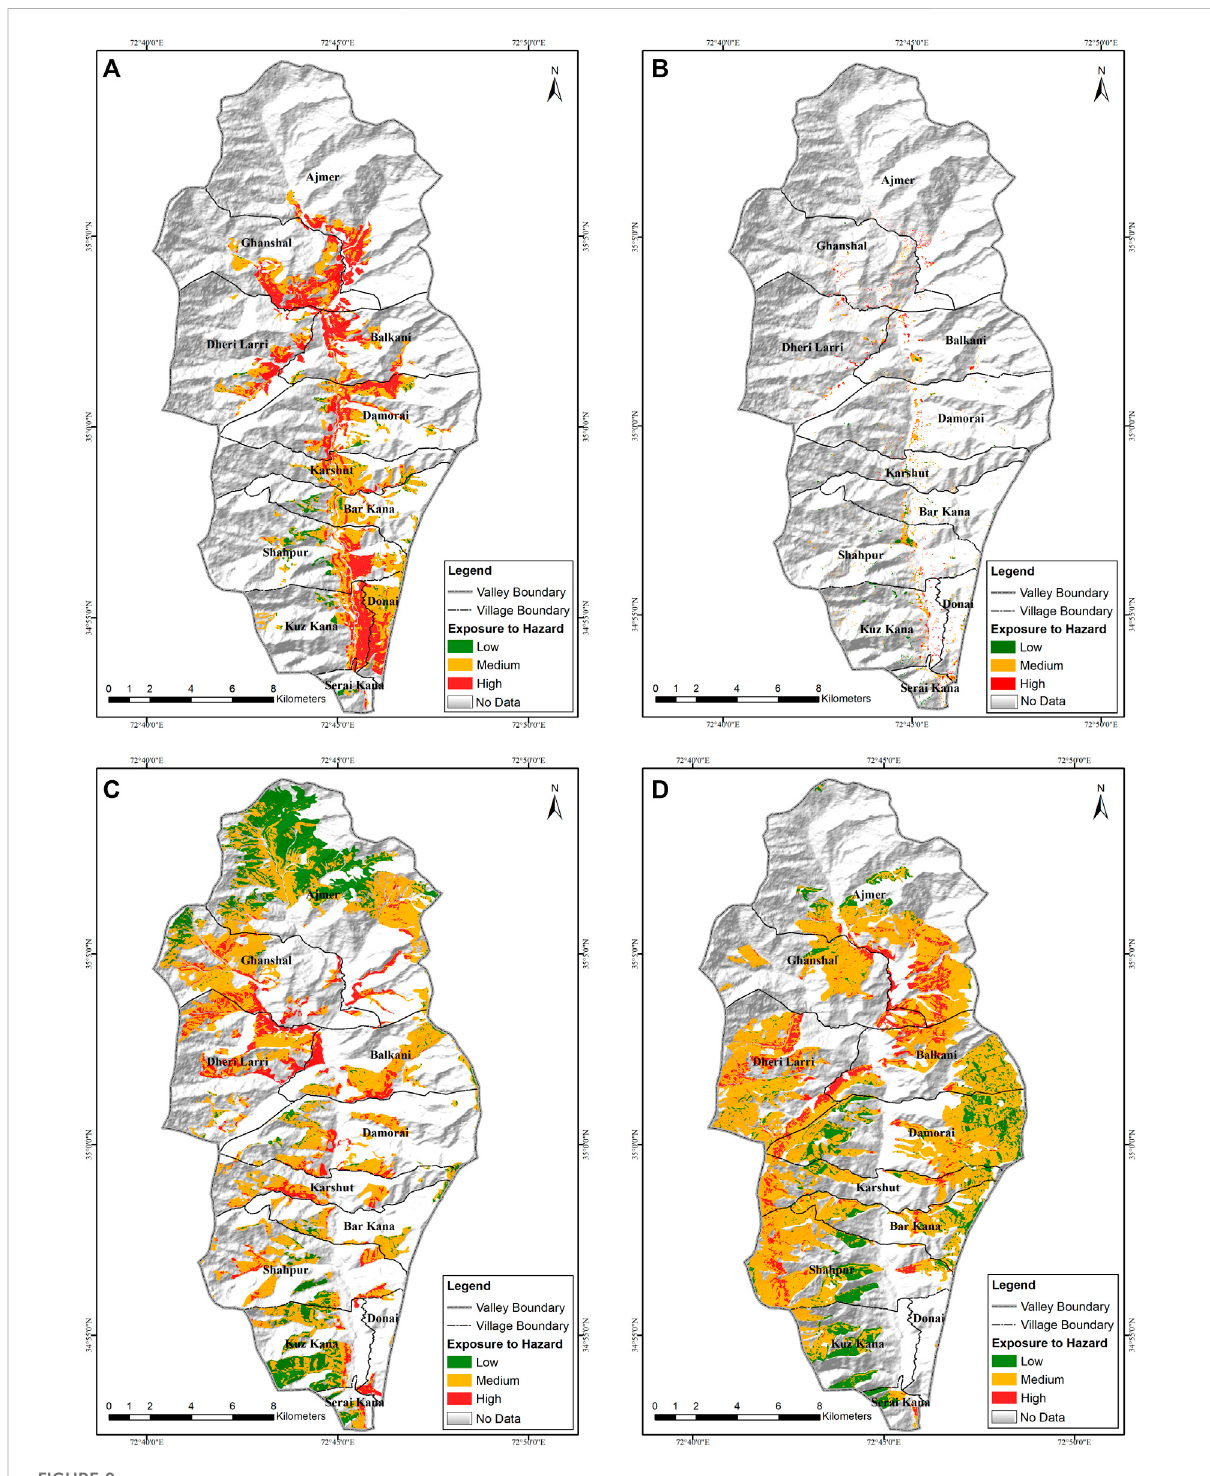
FIGURE 9 Shahpur valley. (A) Agriculture land exposure to the likelihood of landslide occurrence. (B) Settlement exposure to the likelihood of landslide occurrence. (C) Rangelandexposurestothelikelihoodoflandslide occurrence. (D)